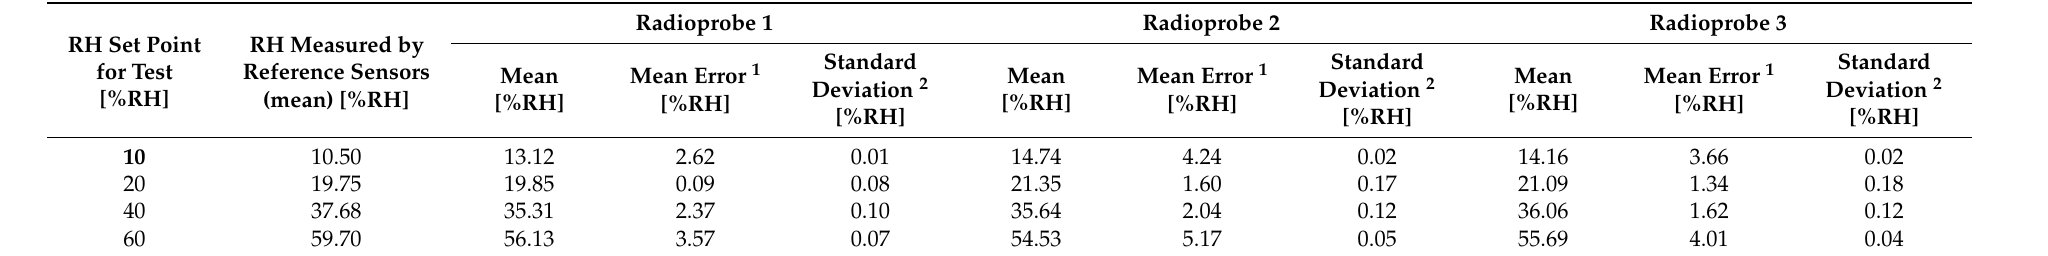
Table 5. Statistical comparison between radioprobe sensors and INRiM reference sensors readings. Relative humidity. RH Set Point for Test is the relative-humidity set to the climatic chamber. RH Set Point RH Measured for Test [%RH]